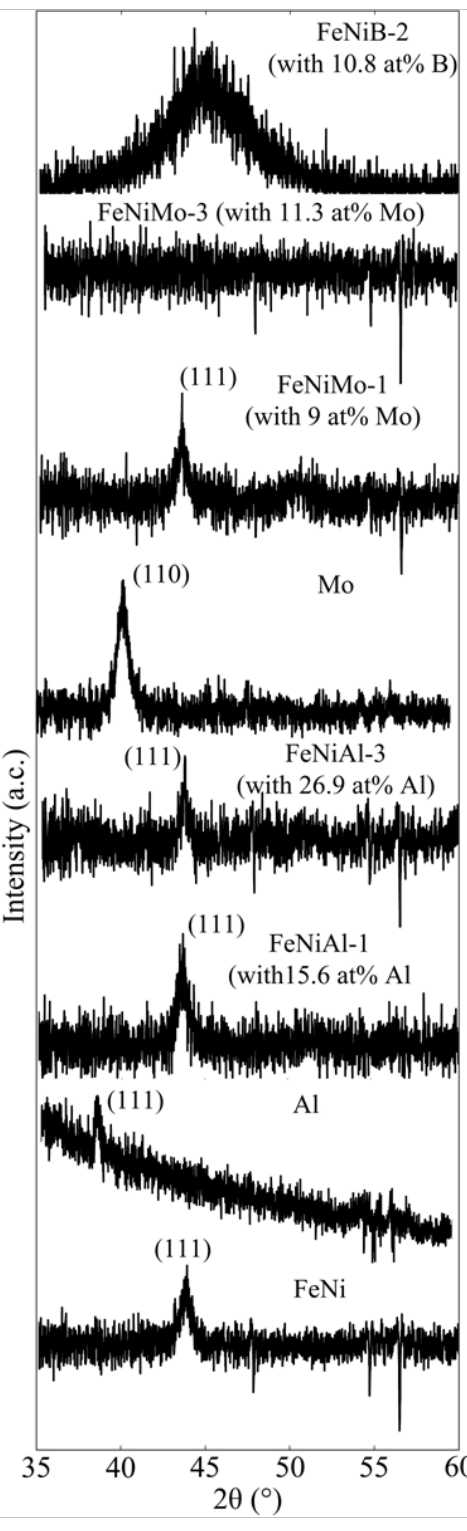
Figure 2. XRD spectrum of thin films, Al, Mo, FeNi, FeNiAl, FeNiMo and FeNiB. Mo exhibited a body-centered cubic (BCC) polycrystalline structure. Al and FeNi exhibited a face-centered cubic (FCC)